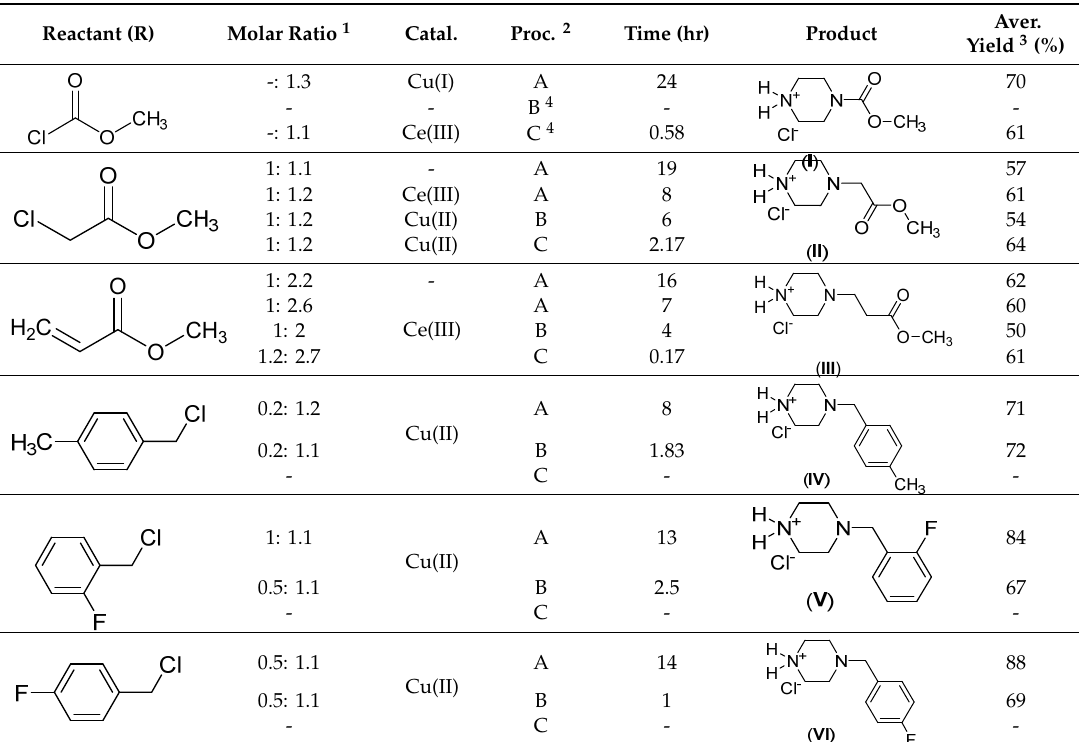
Table 1. Results of syntheses of monosubstituted piperazine derivatives using different synthetic techniques.